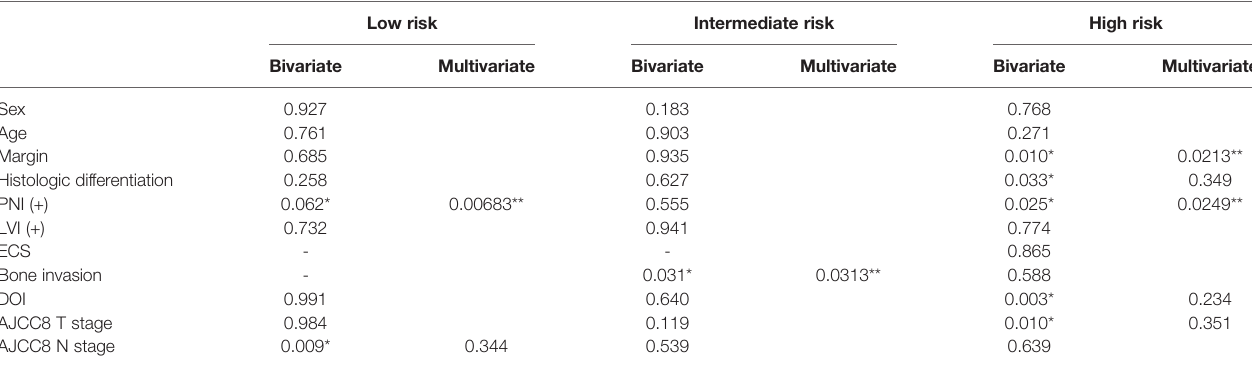
TABLE 2 | Stepwise bivariate and multivariate Cox regression analysis for overall survival